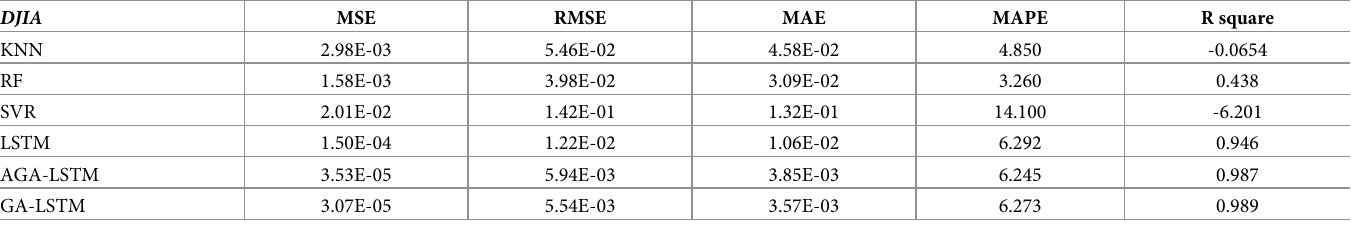
Table 7. The evaluation indexes of AGA-LSTM model and other DL models in DJIA date set.